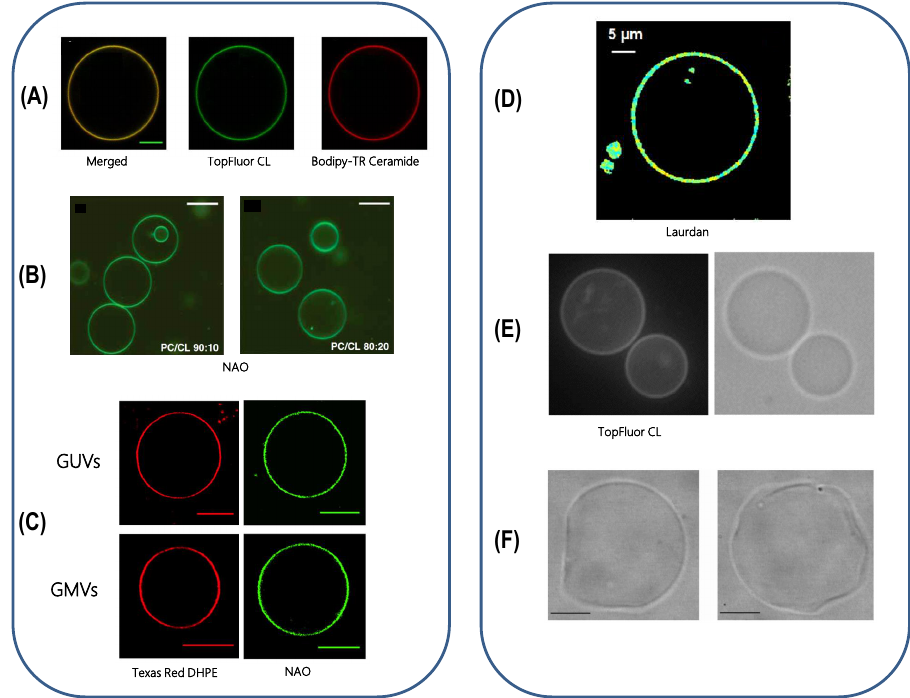
Figure 10. Giant vesicles as model systems. ( A ) Confocal image of a GUV made of EPC/CL 60:40 mol% showing the distribution of Top-Fluor CL (green channel) and Bodipy-TR Ceramide (red channel), 22 ◦ C, scale bar is 5 µm, [80]. ( B ) Confocal microscopy of GUVs made of